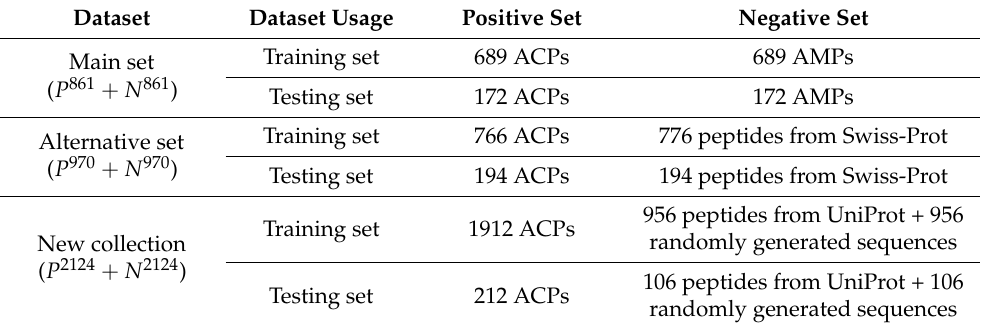
Figure 1. Venn diagram of the positive set of the data sets. Table 1. Comparison of the composition of three data sets. Table 1. Comparison of the composition of three data